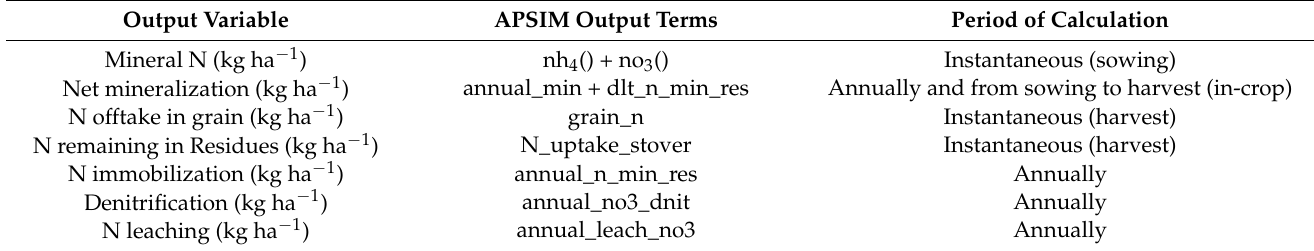
Table 2. Output variables from APSIM and the seasonal timing at which they were obtained or the period of calculation. All soil variables are summed over the maximum rooting depth of the soil (1.3